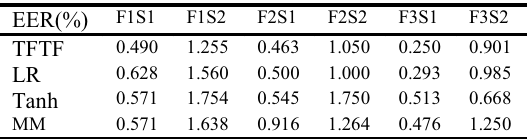
Tab.3. EER comparison between different fusion